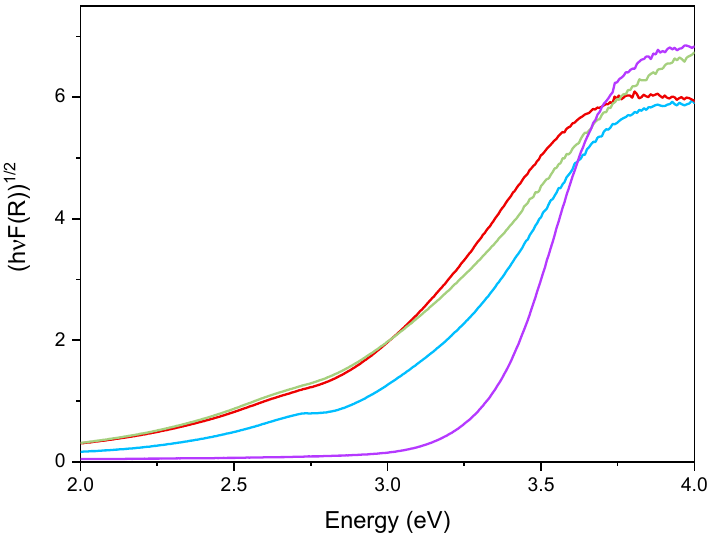
Figure 7. Tauc’s plot applied to the undoped TiO 2 sample (purple line), Fe(3.5)-TiO 2 (green line), Fe(2.5)-TiO 2 (red line), and Fe(1.0)-TiO 2 (light blue line).